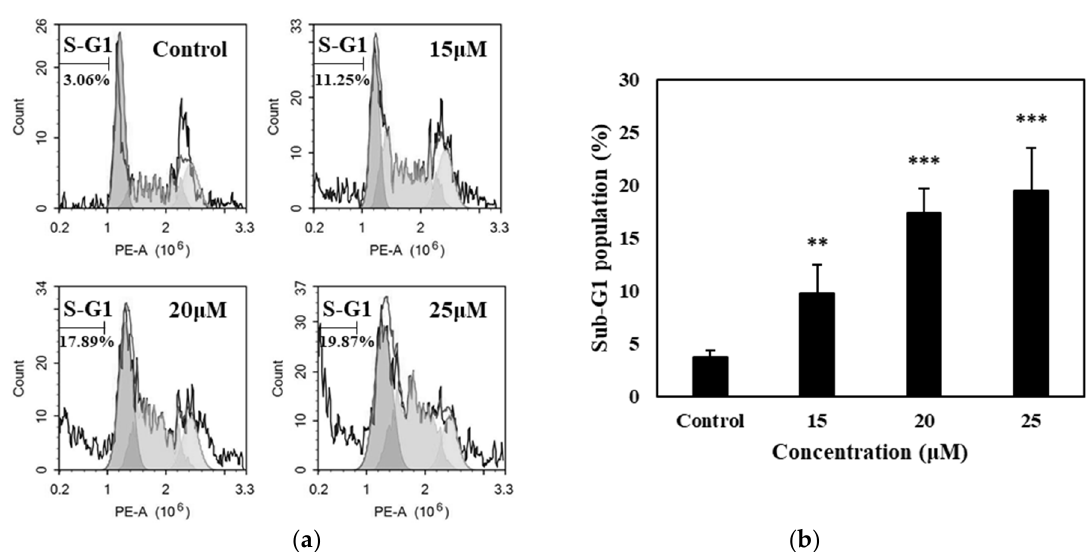
Figure 5. Isoquercitrin increases the sub-G1 population of SK-MEL-2 cells. ( a ) SK-MEL-2 cells were cultured in RPMI medium for 24 h and treated with the various concentrations of isoquercitrin. Sub-G1 population was determined through flow cytometry. ( b ) The Sub-G1 population was quantified. Results are expressed as a percentage. Data values are expressed as mean ± SD of triplicate determinations. Significant difference was established using Dunnett’s test at * P < 0.05, ** P < 0.01 and *** P < 0.001.